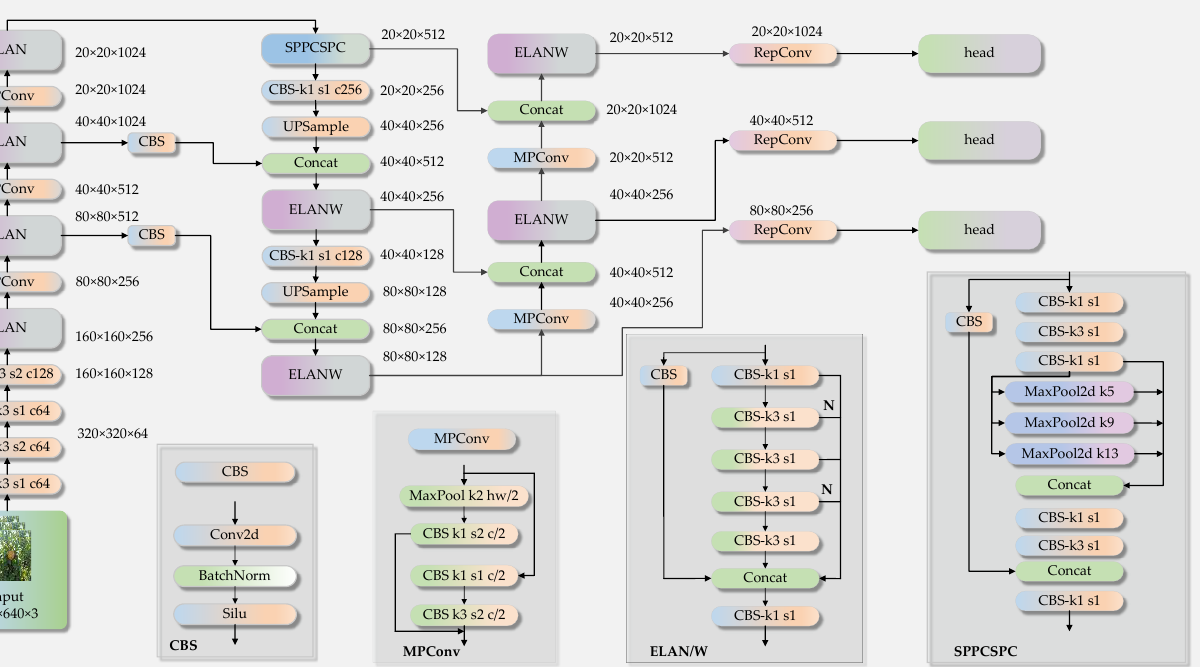
Figure 3. Network structure.